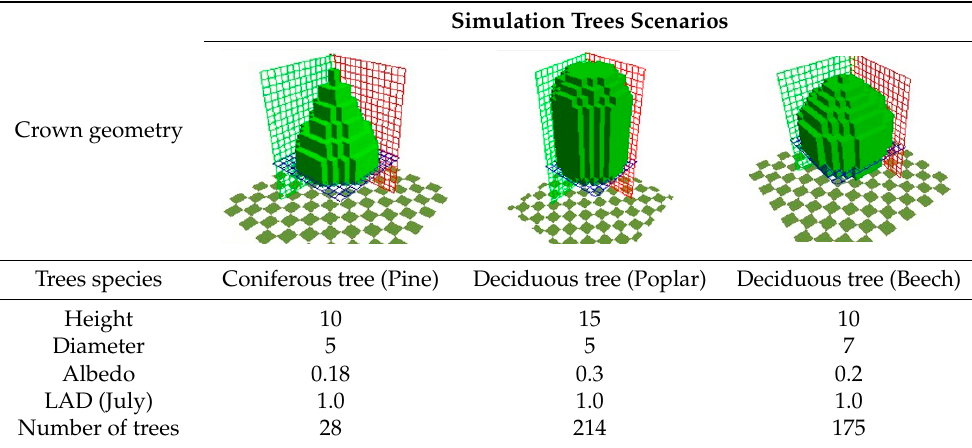
Table 3. Profile alternatives offered to trees.